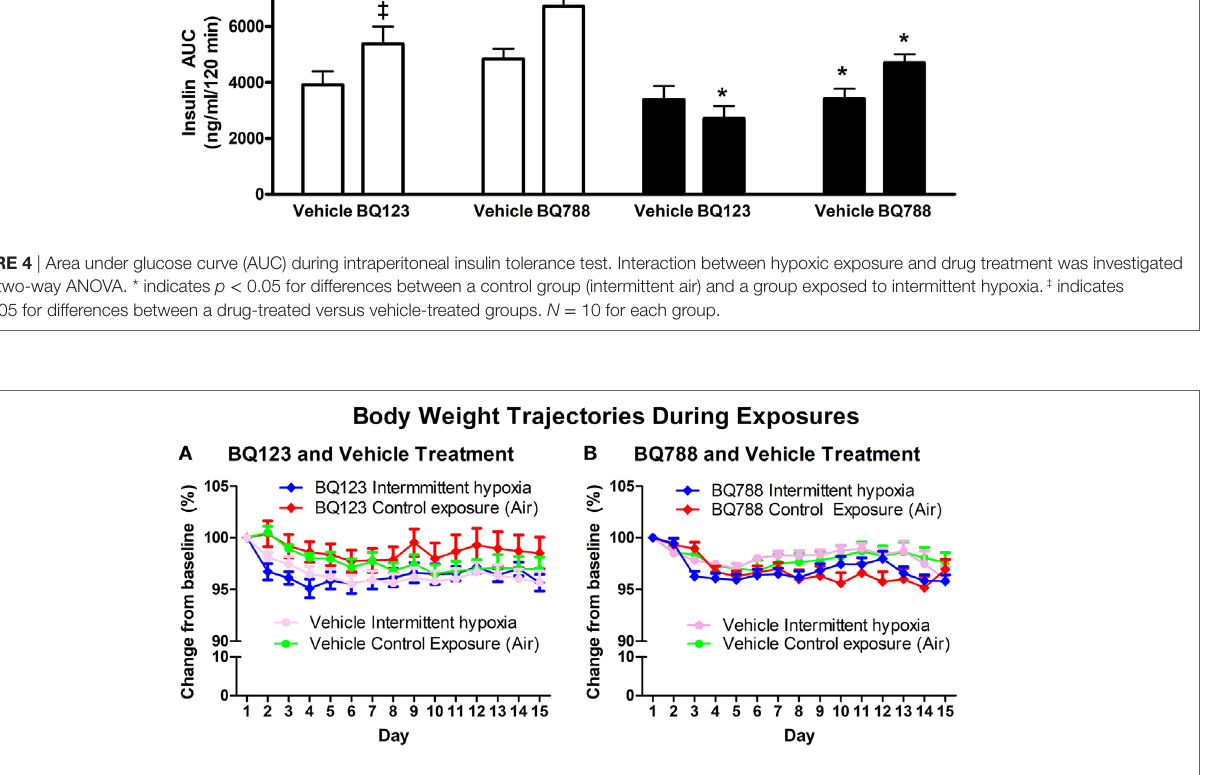
FigUre 5 | Body weight trajectories of vehicle and BQ-123 (a) and BQ-788 (B) treated groups during control exposures and intermittent hypoxia exposure. There were no differences in body weight trajectories between groups (two-way ANOVA). N = 15 for each group.